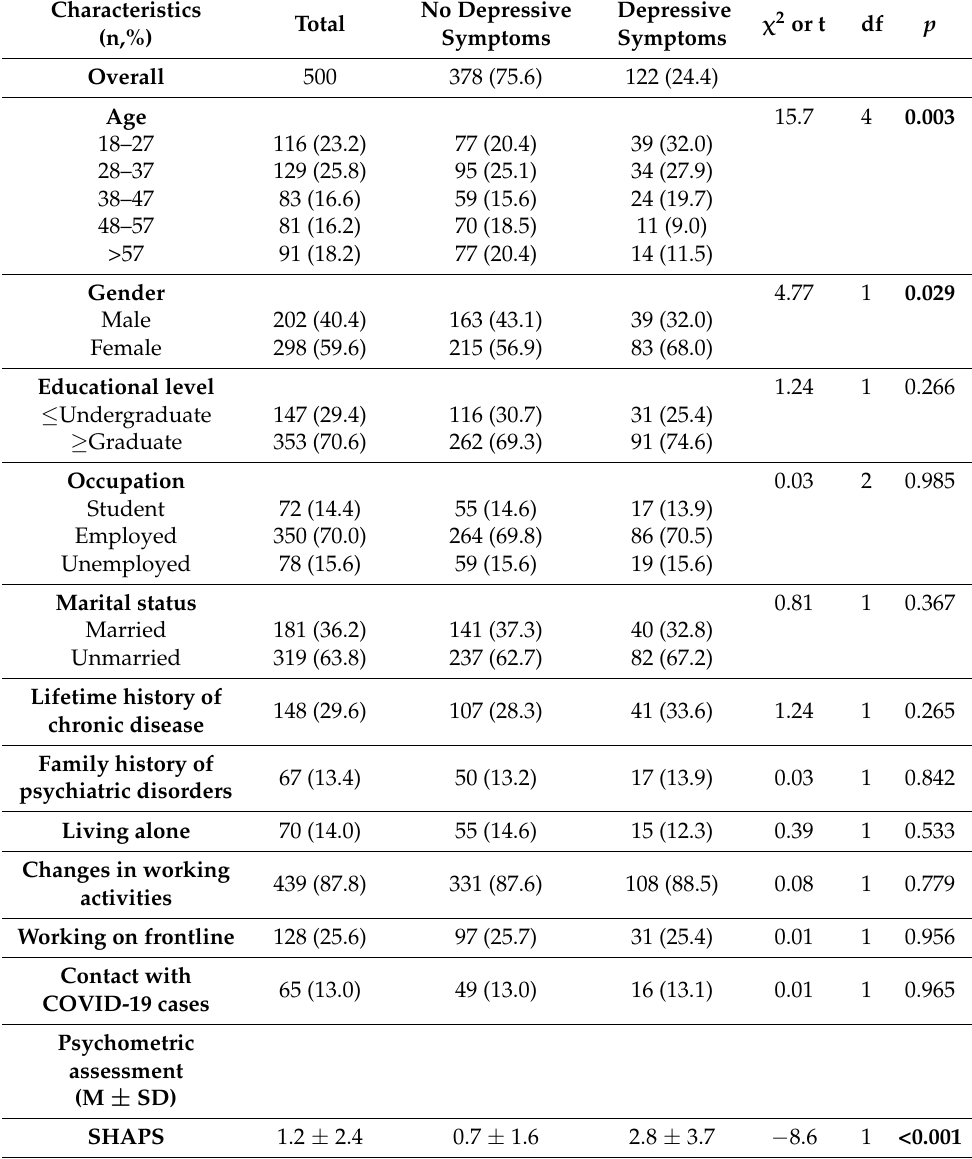
Table 1. Sociodemographic and psychometric